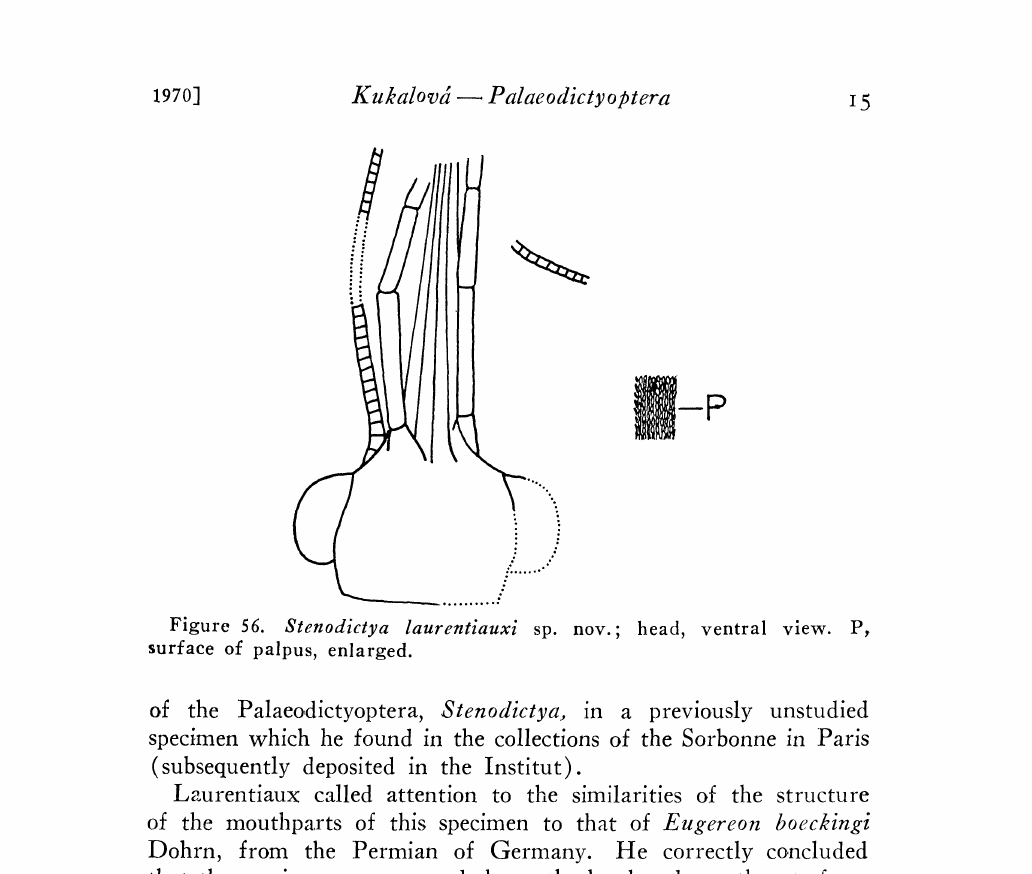
Figure 56. 8tenodictya laurentiauxi sp. nov.; head, ventral view. P, surface of palpus,